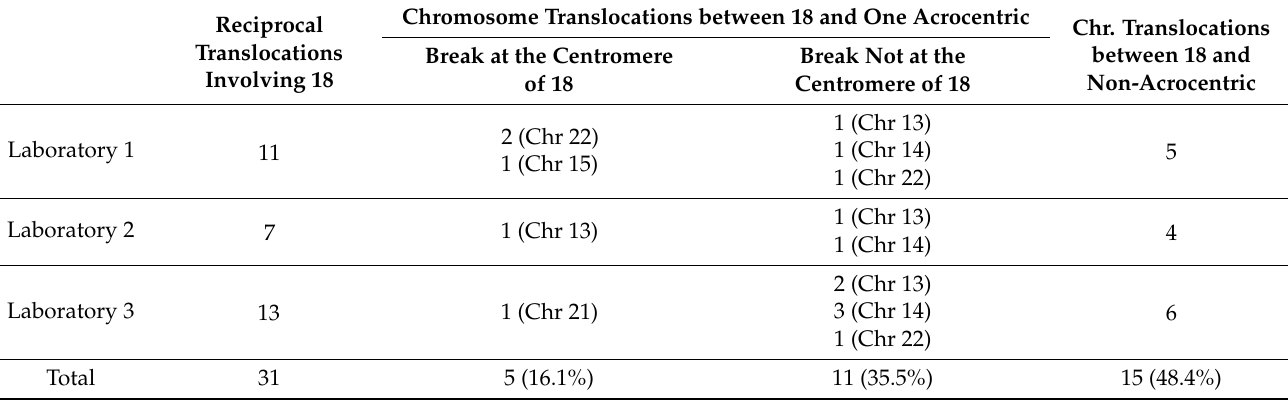
Table 1. Summary of cases described in this